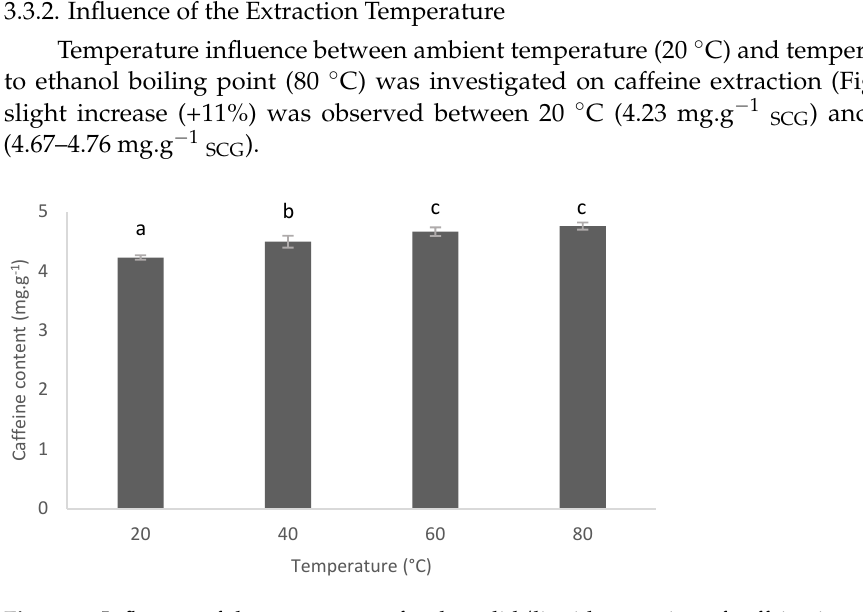
Figure 7. Influence of the temperature for the solid/liquid extraction of caffeine into spent coffee grounds (Experimental conditions: 2 g of SCG for 50. mL of H 2 O/EtOH (60/40 v/v ), during 15 min, magnetically stirred). Values marked by the same letter are not significantly different ( p < 0.05) according to the Student test ( t- test).